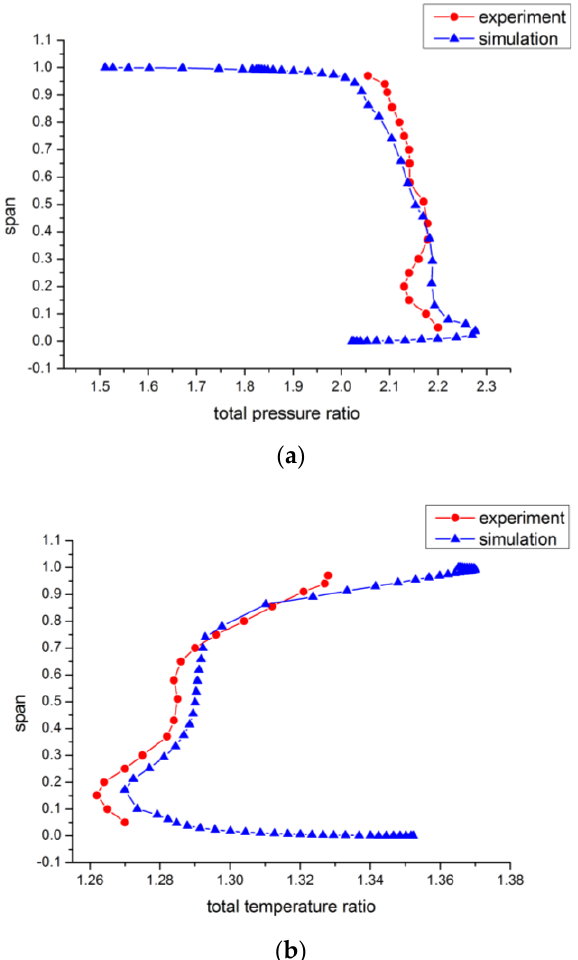
Figure 5. Span distribution of total pressure ratio and total temperature ratio near the stall point. ( a ) Span distribution of the total pressure ratio near the stall point; ( b ) span distribution of the total temperature ratio near the stall point.